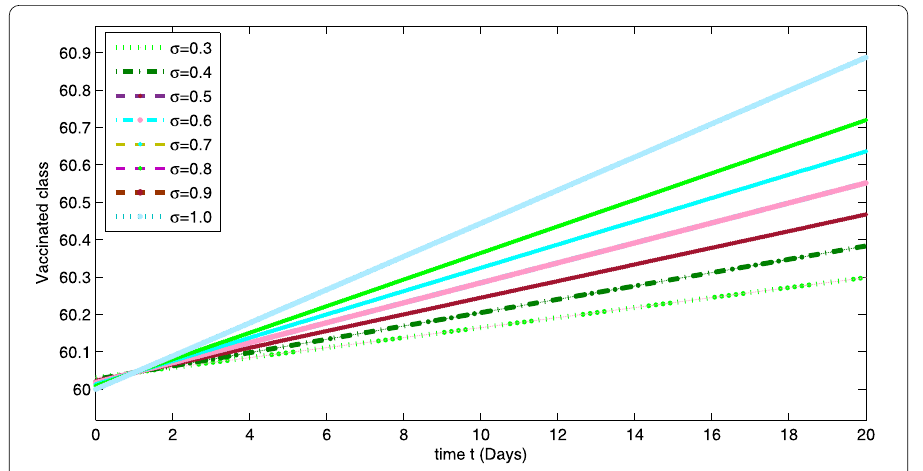
Figure 2 Plot of the vaccinated class of different fractional values for σ